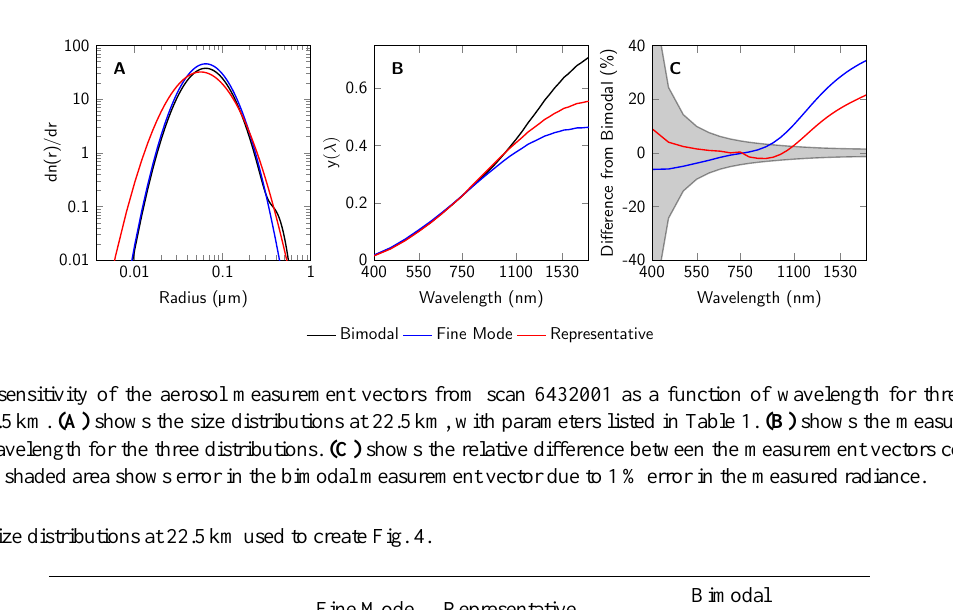
Fine Mode Representative